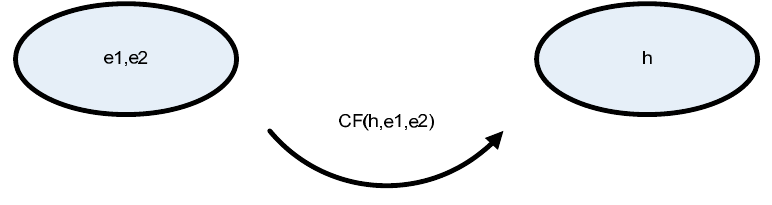
Figure 9. The result of the simplification on the basis of Formulas (6) and (7).